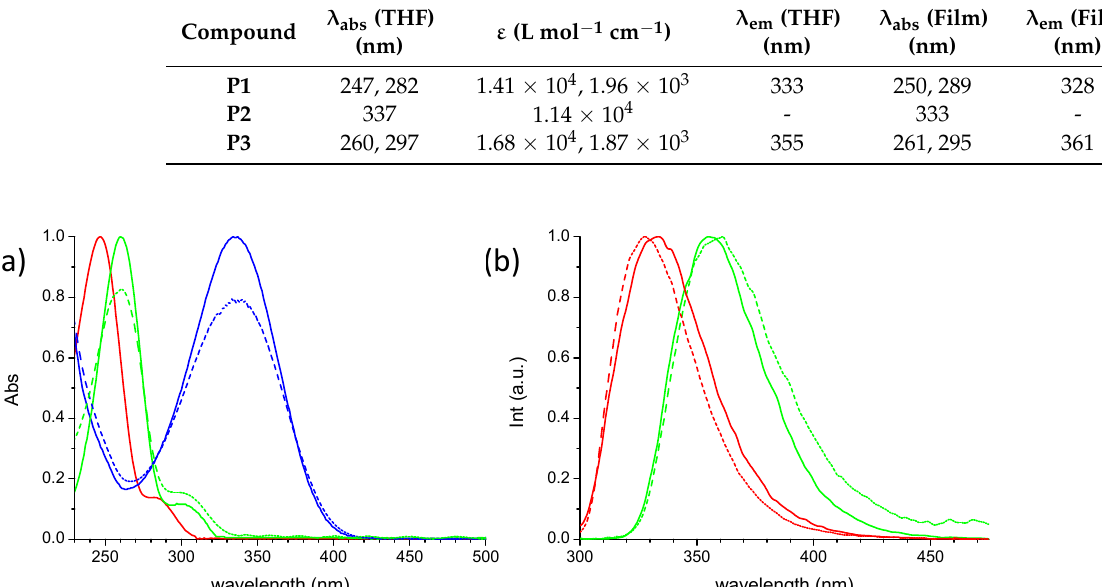
Figure 2. ( a ) UV-Vis absorption spectra and ( b ) fluorescence spectra for P1 (red), P2 (blue), and P3 (green). Data relate to samples studied in solution (solid lines) and in film (dashed lines).